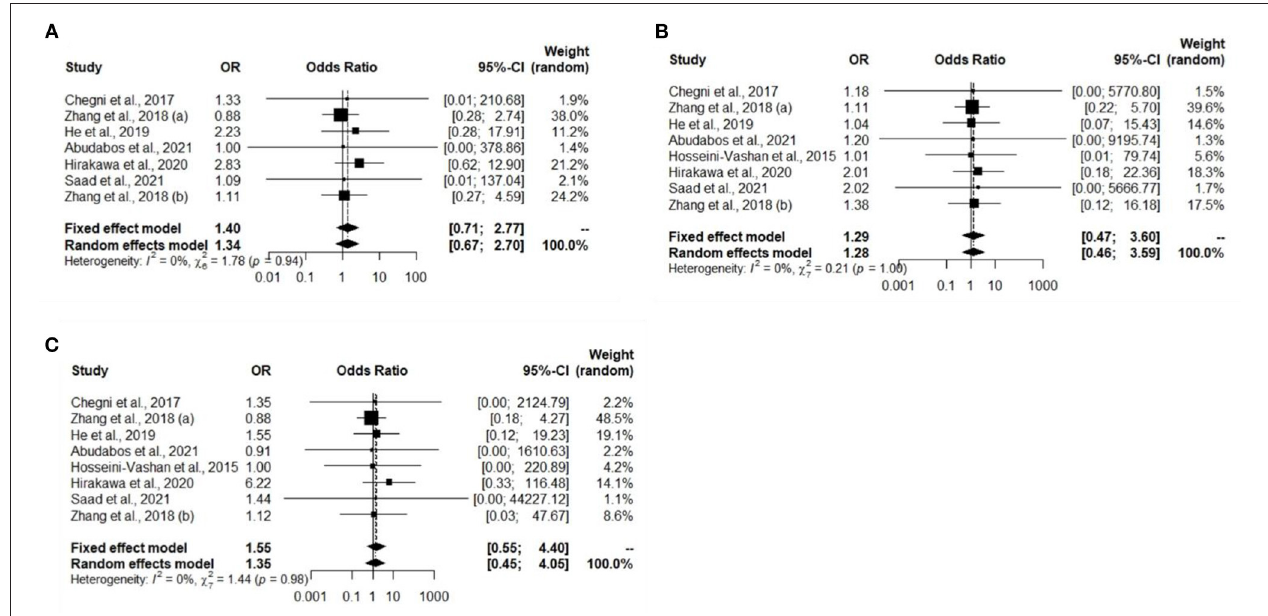
FIGURE 2 | Forest plots representing the effect of heat stress on immune organ mass. (A) Forest plot indicates that the heat stress did not significantly change the thymus mass, (B) forest plot indicates that the heat stress did not significantly changes the spleen mass, and (C) forest plot indicates that the heat stress did not significantly change the bursa of Fabricius mass.